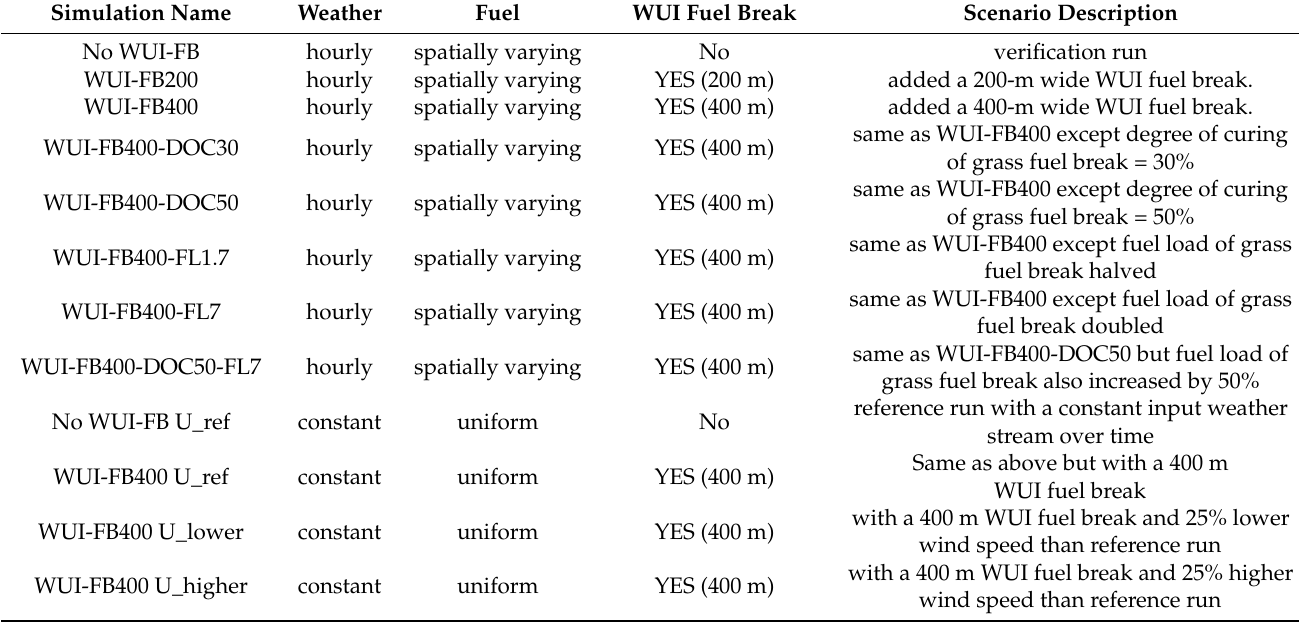
Table 2. Summary of model verification and sensitivity experiments with their scenario descriptions.